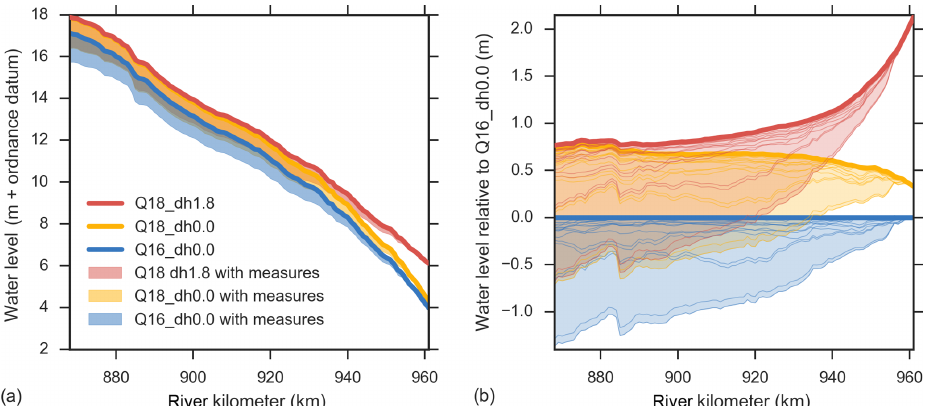
Figure 5. (a) Absolute water level for the three hydrodynamic sets of boundary conditions (solid lines) and the effects of the implemented measures for Q16_dh0.0 and Q18_dh1.8 in the shaded areas. (b) Changes in water level relative to the reference situation, Q16_dh0.0 without measures. The thick lines represent the relative changes without any measures; the thin lines represent the 16 different measures for each set of boundary conditions. Water flows left to